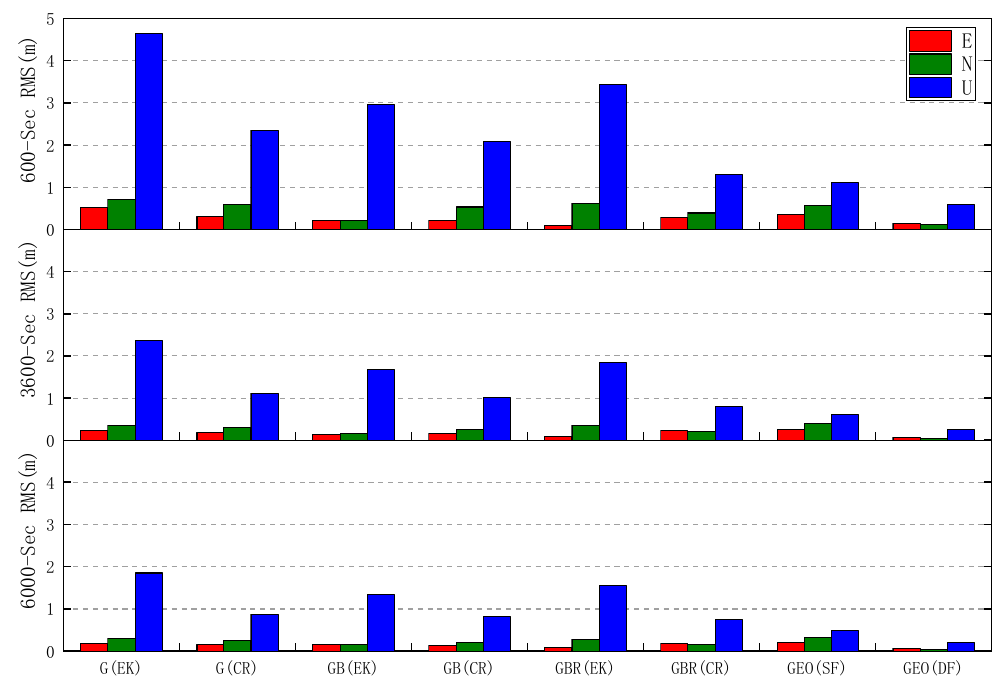
Figure 7. Comparison of the RMS of static PPP errors with respect to GPS, GPS / BDS, and GPS / BDS / GLONASS observed by the Huawei Mate30 in 10, 60, and 100 min. The RMS of single frequency and dual frequency PPP errors of the geodetic receiver during the same time period is presented for comparison. GEO denotes geodetic receiver; SF and DF denote single frequency and dual frequency, respectively.